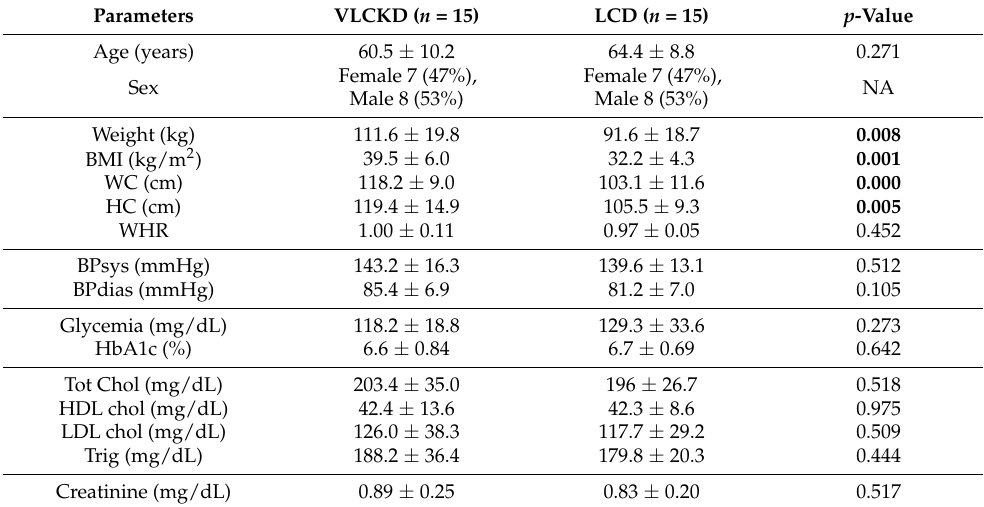
Table 1. Baseline characteristics ( ± SD) of very-low-calorie ketogenic diet (VCLKD) and low-calorie diet (LCD)